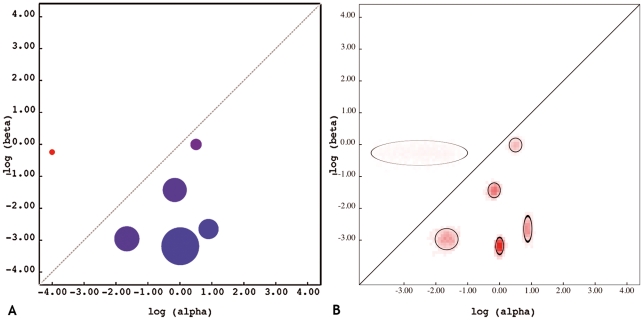
Codon substitution rate classes of GII.4 capsids.A) Inferred weights for each evolutionary rate class, showing the relative proportion of sites belonging to the given classes. The diagonal line divides the regimes of positive selection (dN/dS>1, above) and negative selection (dN/dS<1, below). B) Approximate inferred posterior distribution of synonymous (alpha) and non-synonymous (beta) substitution rates, showing the variance of each rate estimate. Color intensity is proportional to the square root of the density, and solid oval plots delineate approximate 95% confidence sets.